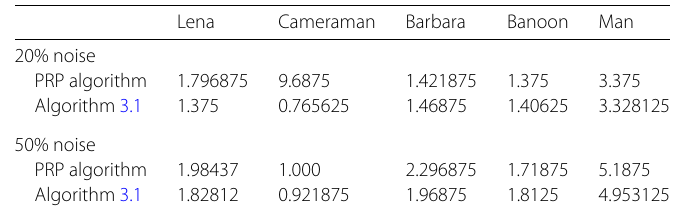
Table 1 The CPU time of PRP algorithm and Algorithm 3.1 in